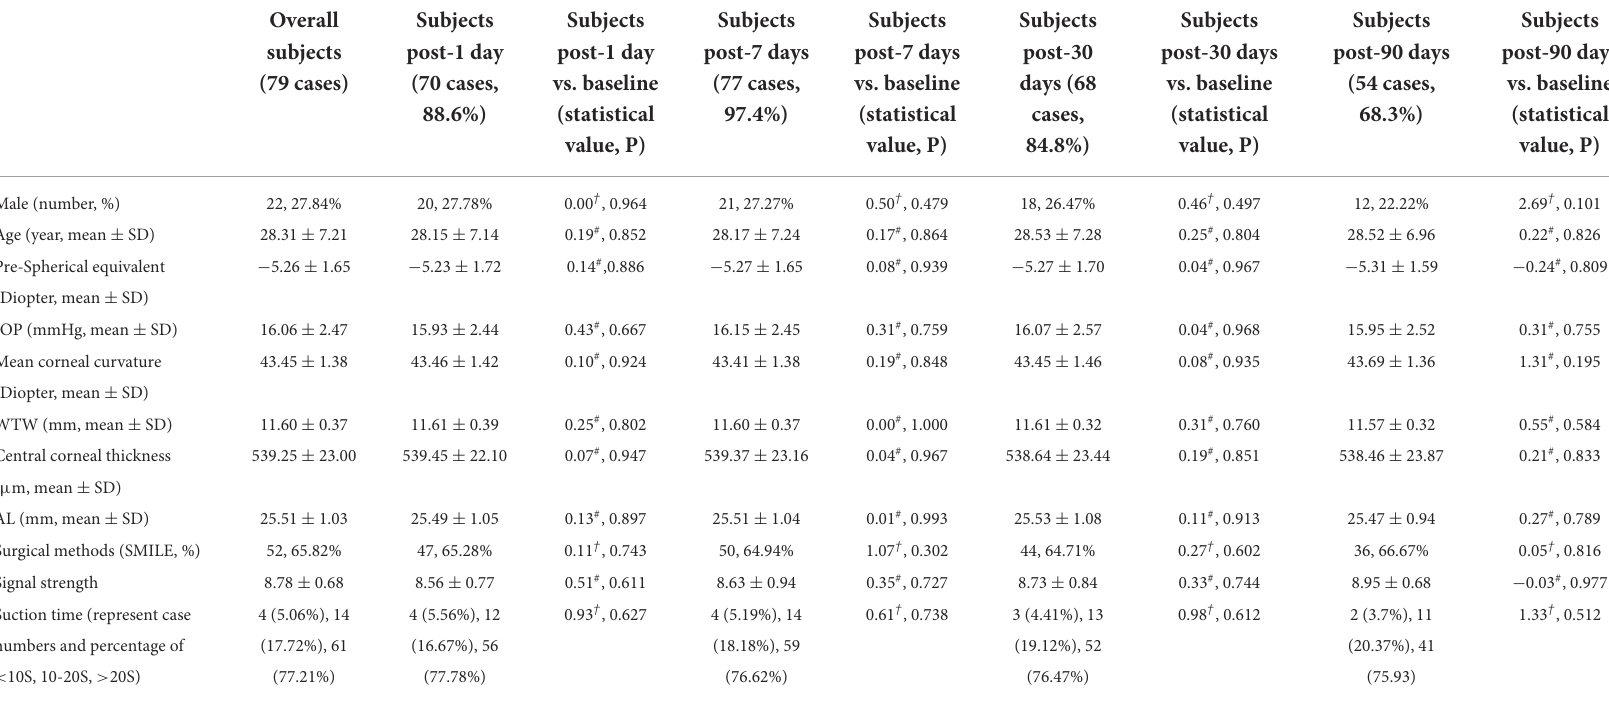
TABLE 2 Comparison of baseline parameters of patients at different post-operative follow-up points with overall 79 cases.